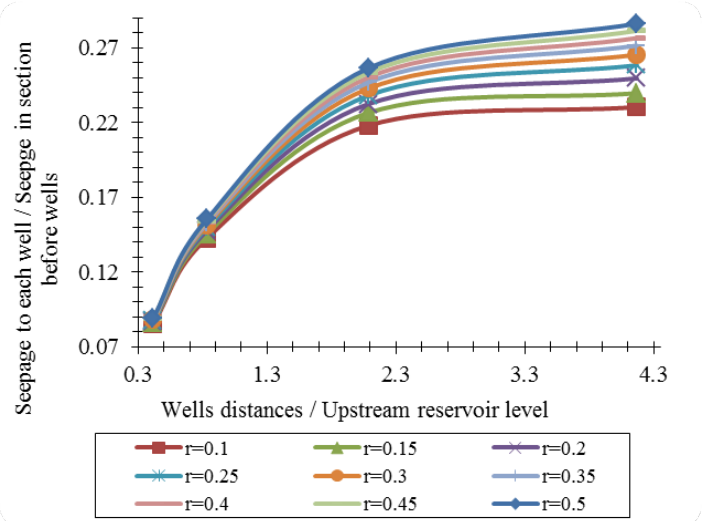
Fig. 3. Variation of relief wells distance against seepage value to each well (upstream reservoir level=12